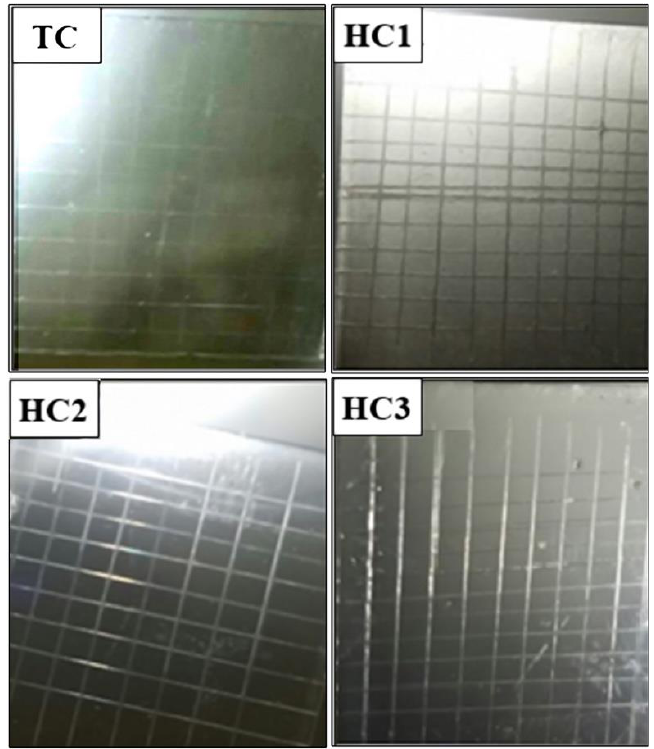
Figure 7. Photographs corresponding to samples tested by cross-cut test method described in ASTM D3359-17.